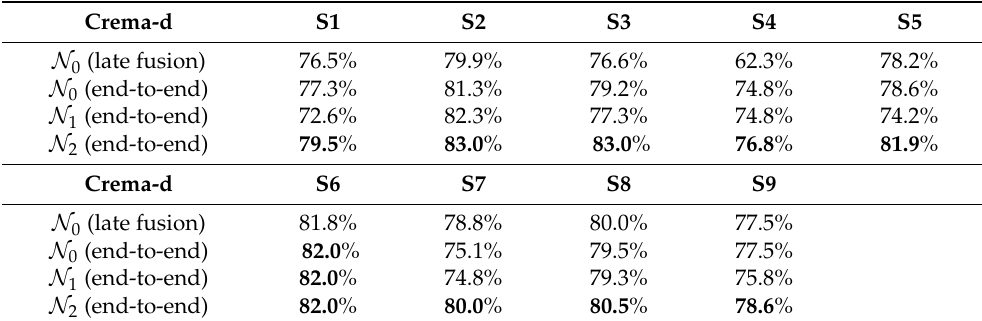
Table 3. Comparison for Crema-d of MRPN approach (network N 2 ) with simple fusion strategy ( N 0 ), and advanced fusion strategy ( N 1